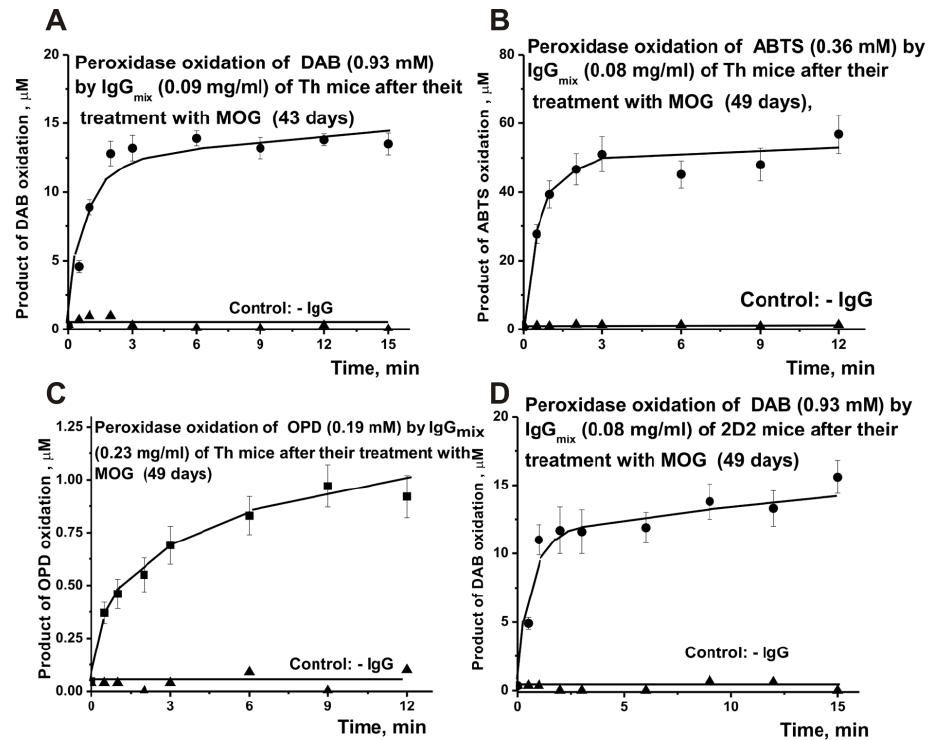
Figure 2. Typical examples of the time dependences of different product formations in the reaction of three substrates (ABTS, DAB, and OPD) due to their oxidation by IgG mix preparations in the presence of H 2 O 2 . All of the designations are given in Panels ( A – D ).